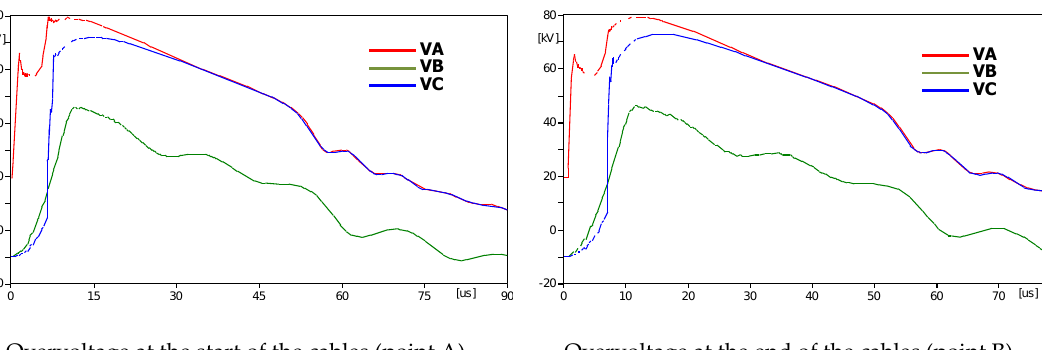
Figure 42. A 100 m underground cable.